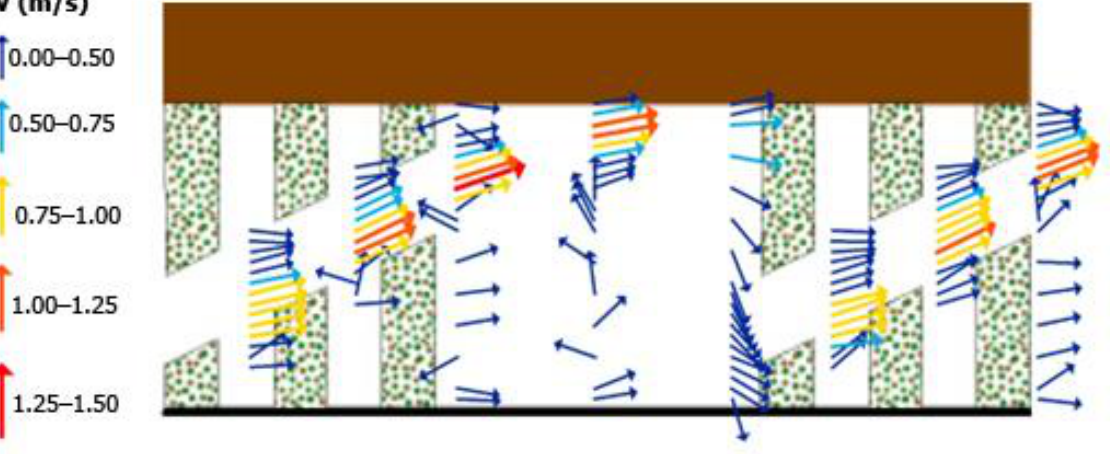
Figure 15. Velocity field in the diagonal-brush fish pass in the physical model. Discharge = 0.4 m 3 /s, channel width = 2 m, and bed slope = 4%. Adapted from Rahn [3].